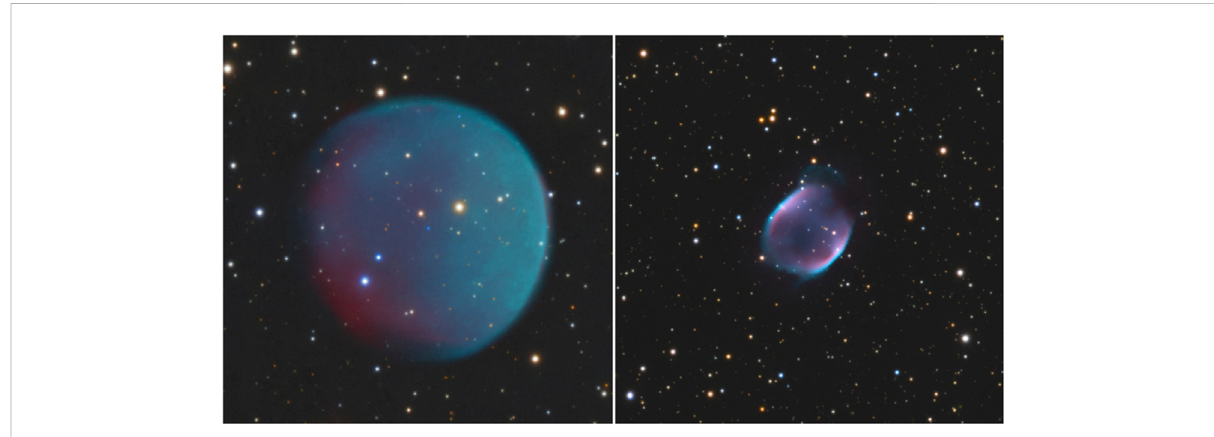
FIGURE 9 Deep amateur multi-narrow band RGB images of two recently con fi rmed amateur PN discoveries StrDr 140 (HASH ID 33480) and StDr 141 (HASH ID 33483). A faint blue CSPN is evident in both. Left: StDr 140 with a diameter of 414 arcseconds. Imaging by Peter Goodhew with processing